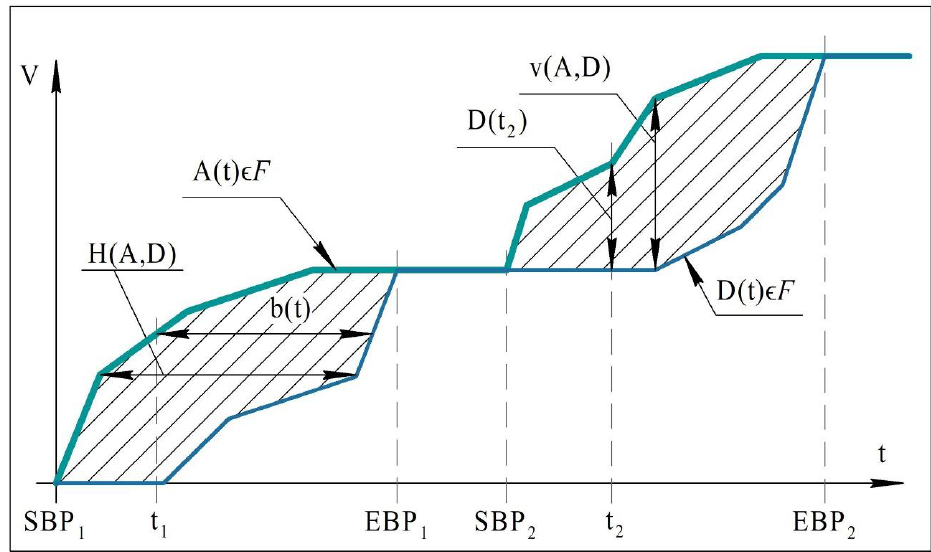
Figure 2. Graphical representation of pair of cumulative functions A, D  F,  A, D  S, simulating the processes of data arrival to handler S and their further